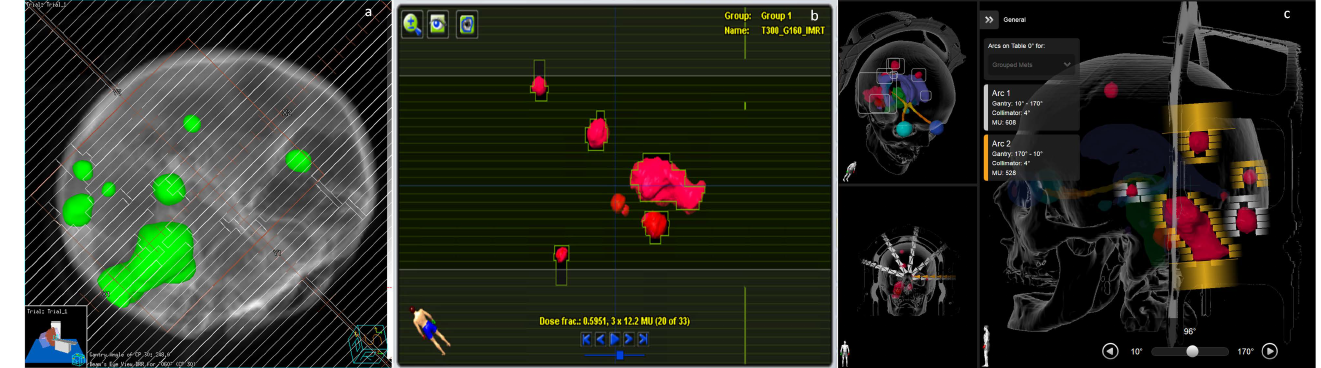
Figure 5. The beam’s eye view of VMAT arc ( a ), dynamic IMRT field ( b ), and MBM Elements v.2.0 arc ( c